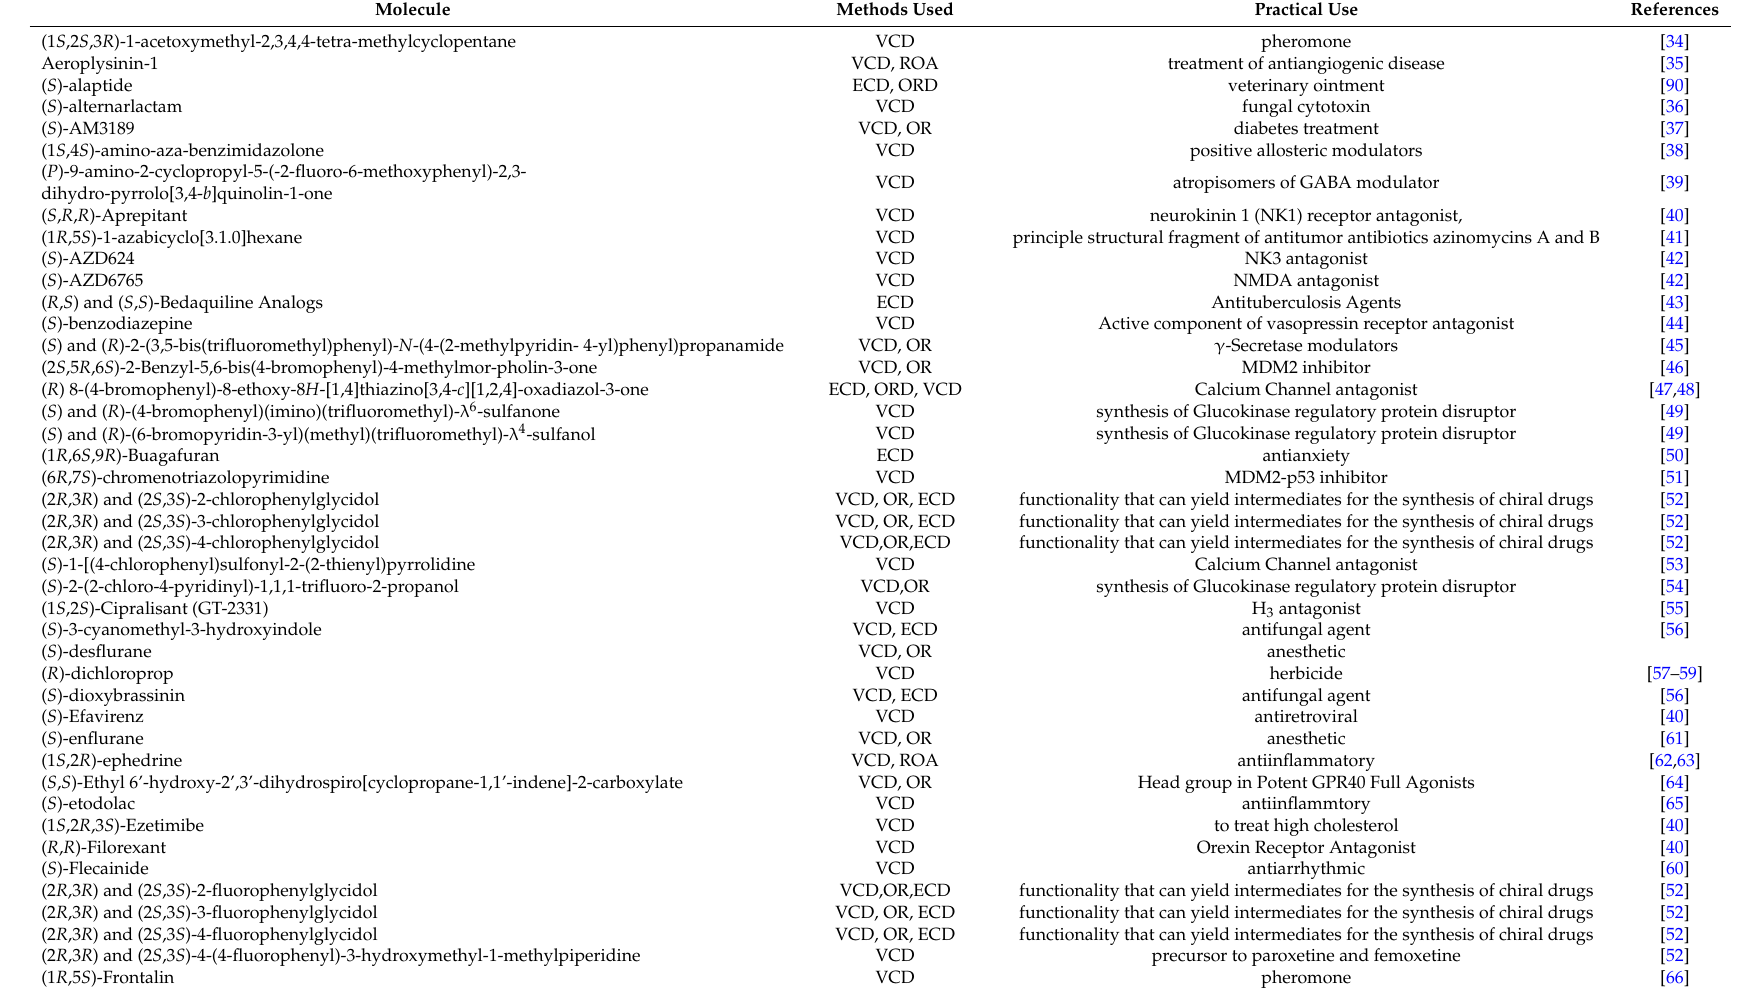
Table 1. Chiral molecules with pharmaceutical applications investigated for their absolute